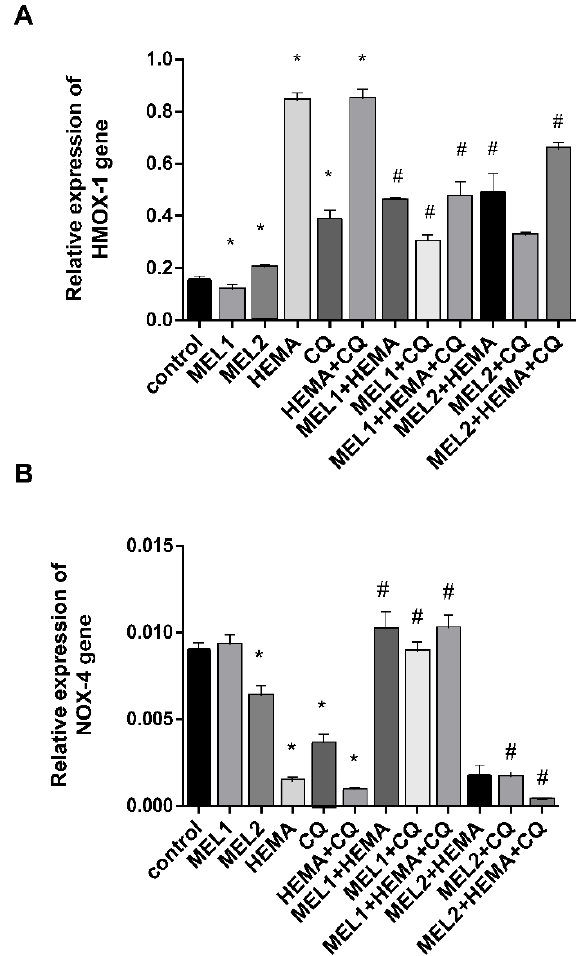
Figure 4. HEMA- and/or CQ-induced effects on HMOX1 ( A ) and NOX4 ( B ) gene expression levels in human dental pulp cells in the presence of melatonin (24 h). Each graph bar represents the mean ± SD of four experiments. * p < 0.05 chemical vs. control; # p < 0.05 chemical with melatonin vs. without melatonin. HMOX1—heme oxygenase-1 gene; NOX4—NADPH oxidase-4 gene; MEL1 (0.1 mM) and MEL2 (1 mM)—melatonin; HEMA—2-hydroxyethyl methacrylate (5 mM); and CQ—camphorquinone (1